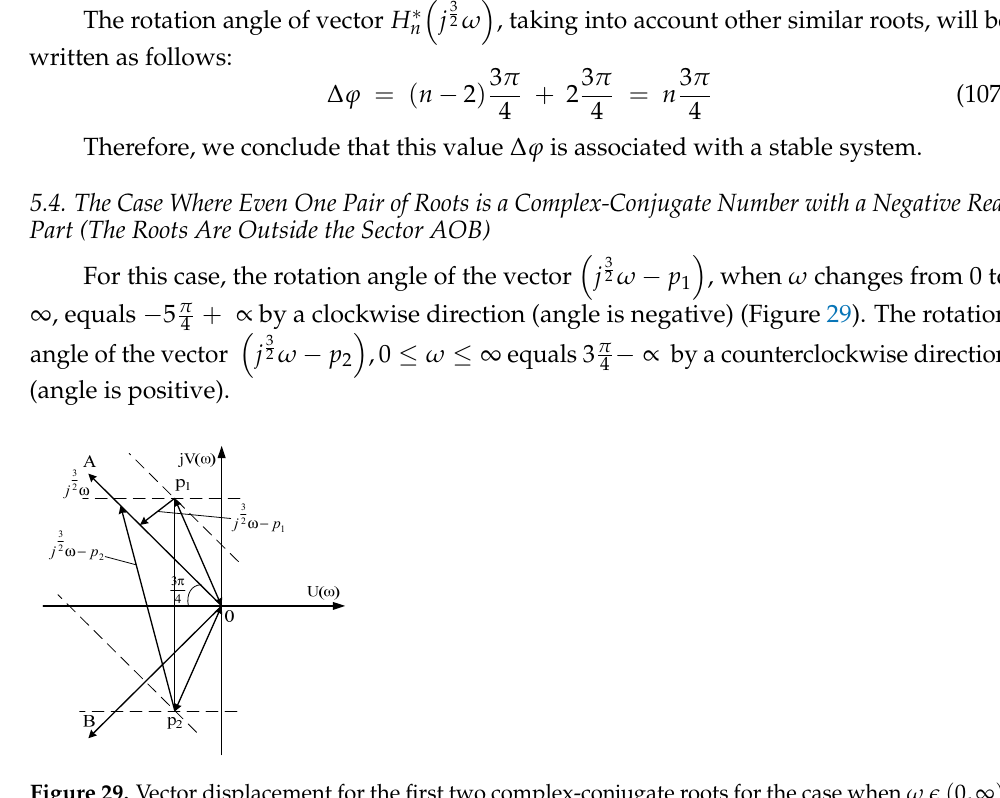
Figure 28. Vector displacement for the first two complex-conjugate roots for this case provided by 𝜔 𝜖 (0, ∞) .